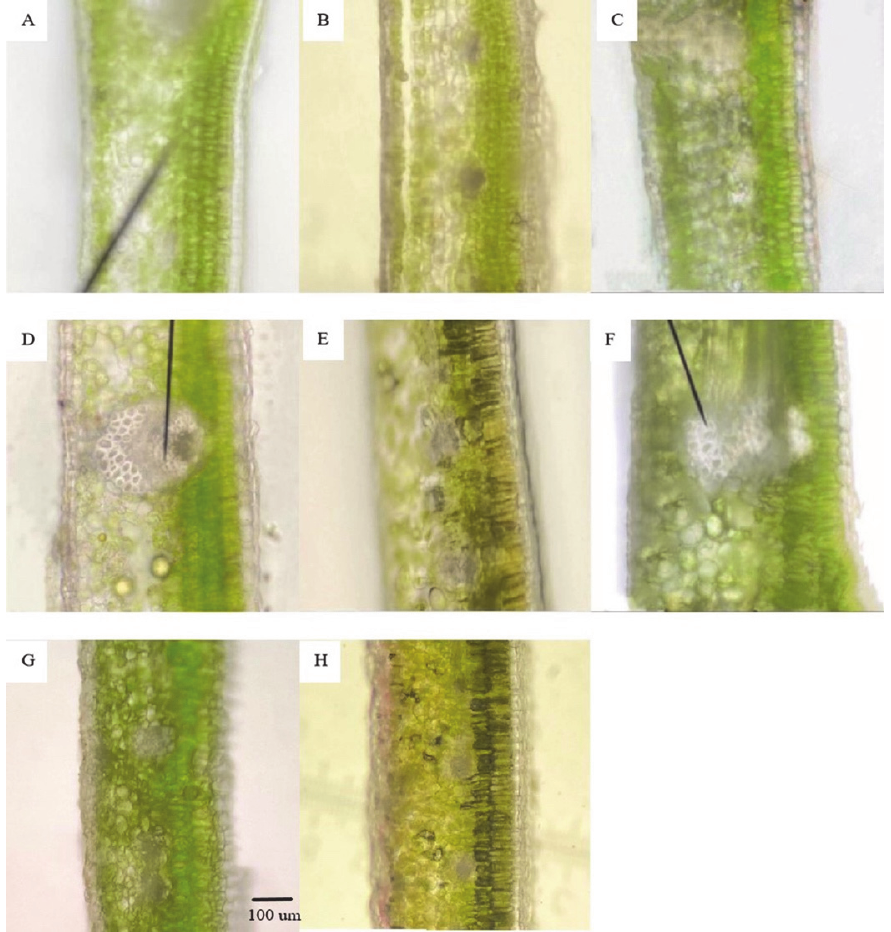
Figure 2. Schematic diagram of leaf anatomical structure. ( A ) September2020, E. japonicus Beihaidao; ( B ) December2020, E. japonicus Beihaidao; ( C ) May2021, E. japonicus Beihaidao; ( D ) September2020, E. oblongifolius ; ( E ) December2020, E. oblongifolius ; ( F ) May2021, E. oblongifolius ; ( G ) September2020, E. microcarpus ; ( H ) December2020, E. microcarpus.